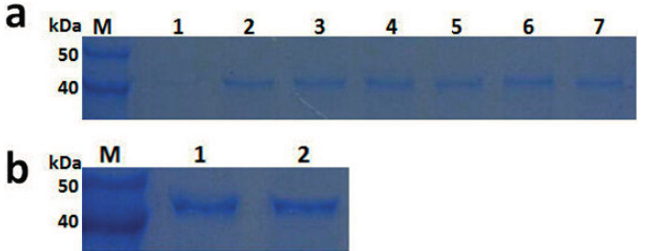
Figure 3. SDS-PAGE analysis of recombinant PGC3 from FOC1 and FOC4 produced in P. pastoris . ( a ) Cultures were induced with methanol as described in Experiment Section and supernatants from 1, 2 to 3 day were collected. Lane M: protein marker; Lane 1: cultures transformed with pPICZaA; Lane 2–4: culture supernatant from FOC1 at 1, 2, and 3 day; Lane 5–7: culture supernatant from FOC4 at 1, 2, and 3 day; ( b ) SDS-PAGE analysis of purified PGC3 from FOC1 and FOC4 produced in P. pastoris . Lane M: protein marker; Lane 1: purified r-FOC1-PGC3; Lane 2: purified